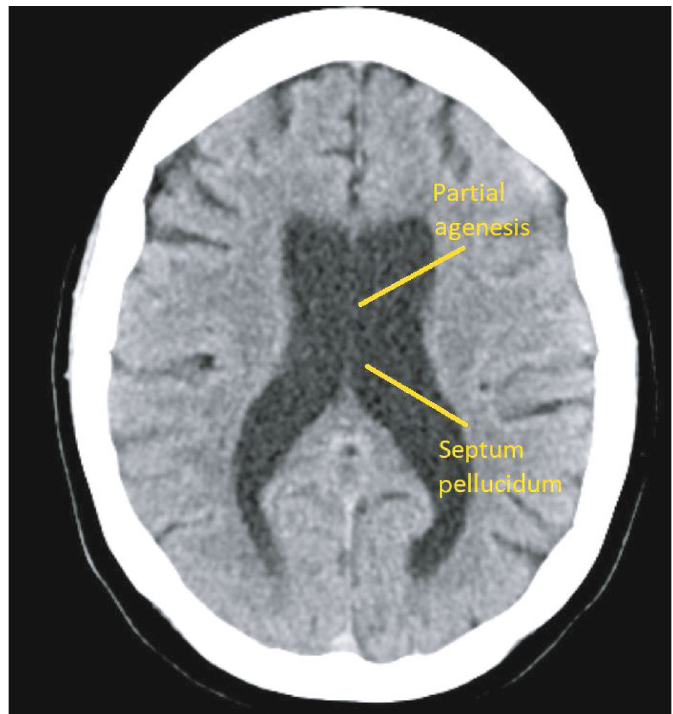
Figure 1: Axial MRI showing septum pellucidum agenesis.